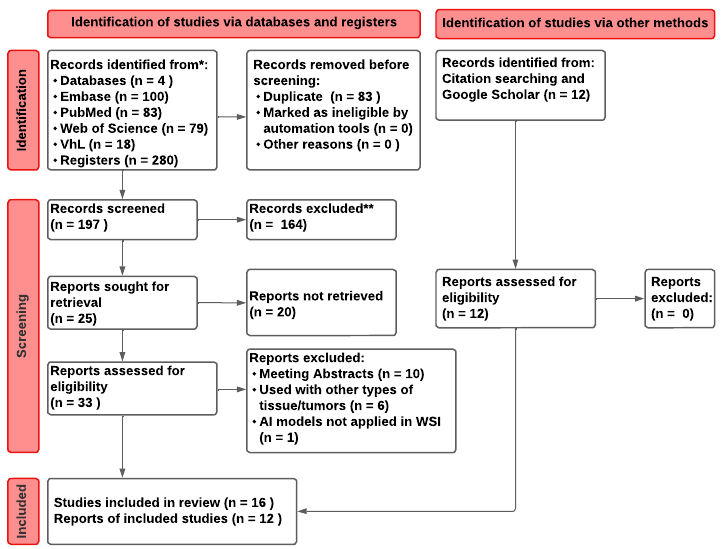
Figure 1. PRISMA flow diagram describing the search and selection process carried through for this systematic review [11].